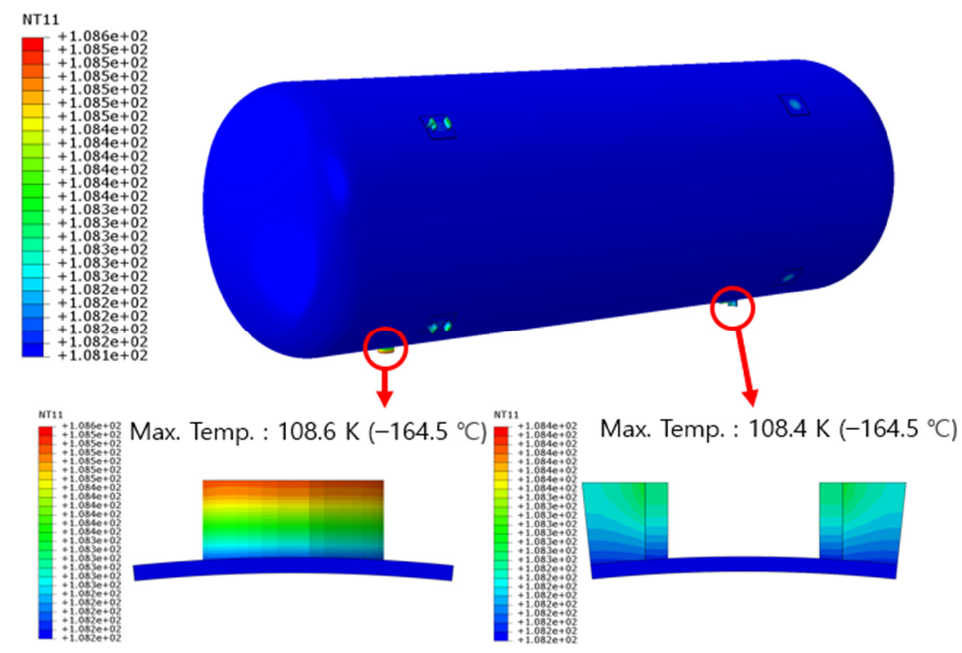
Figure 7. Temperature distribution of inner tank (AL-5083-O).